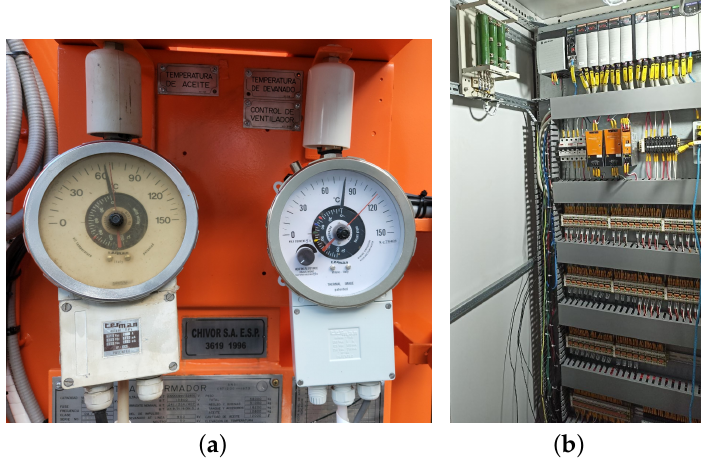
Figure 11. Temperature ( a ) instrumentation and ( b ) installed PLC for data acquisition.